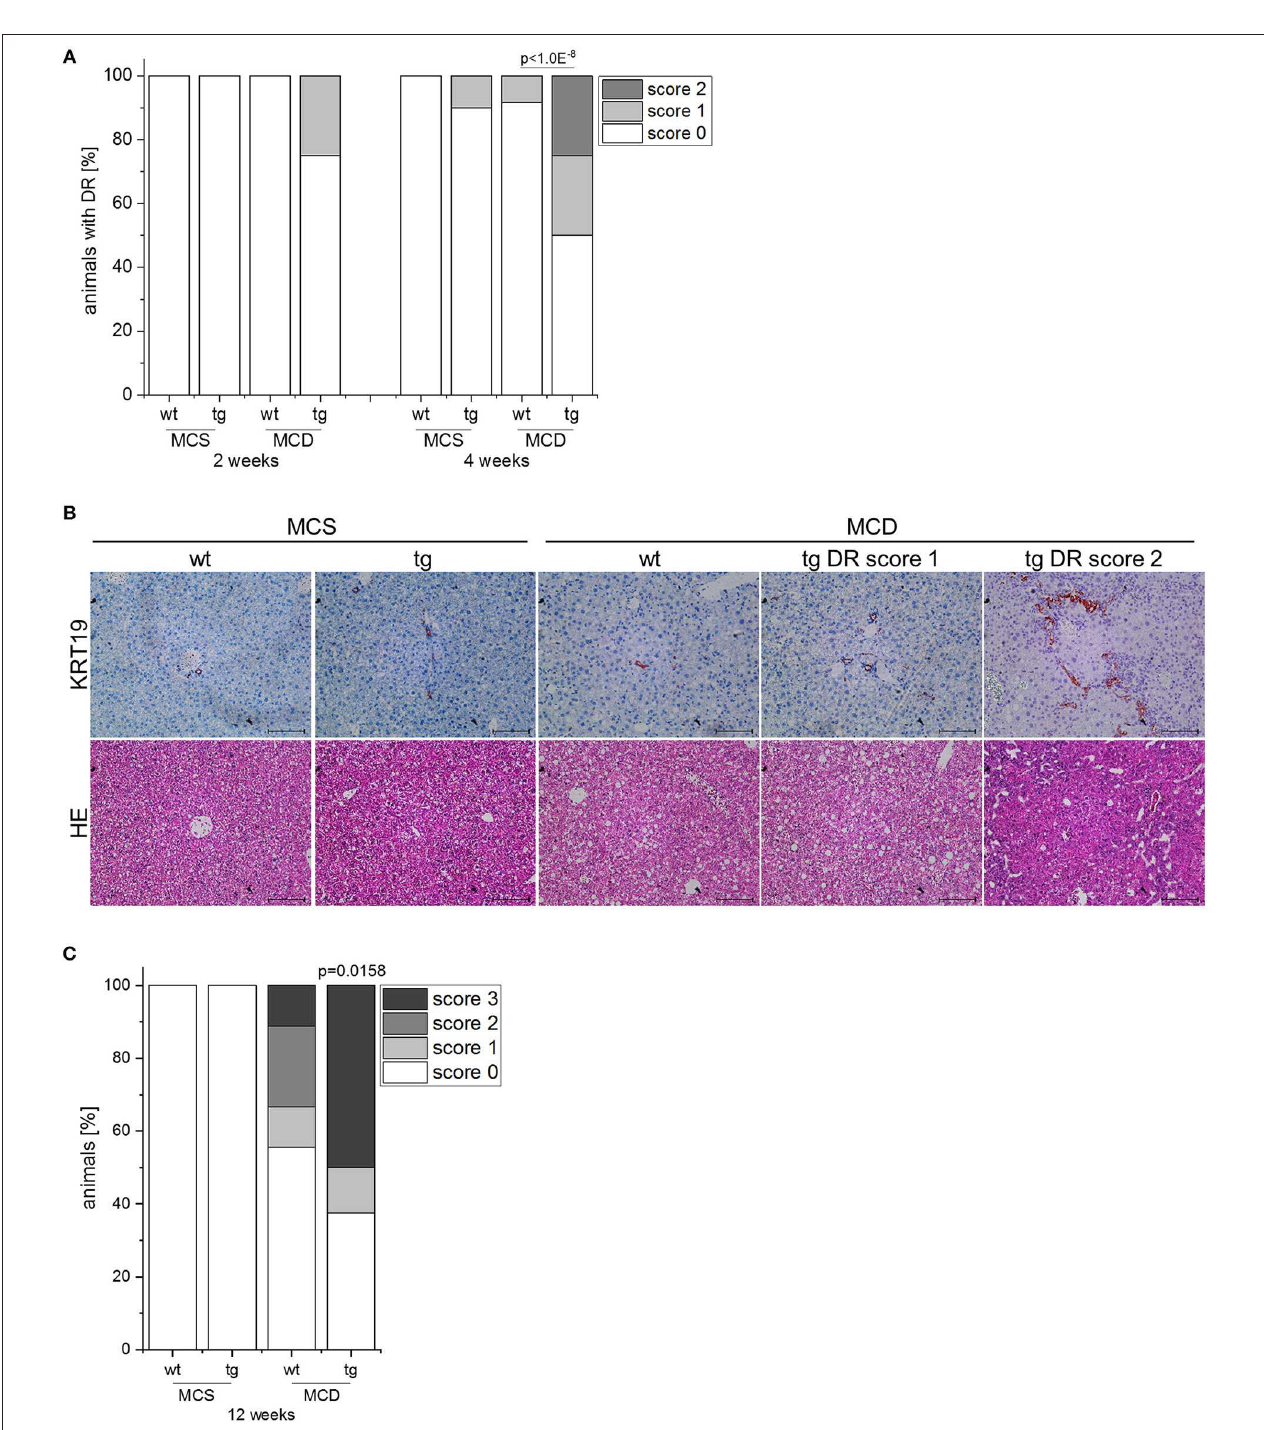
FIGURE 3 | IMP2-2 expression accelerates DR in the MCD model. (A) Histological scoring of DR in IMP2-2 transgenic (tg) and wildtype (wt) mice, which were fed either a methionine-choline deficient (MCD) diet or a methionine-choline supplemented (MCS) control diet for 2 and 4 weeks (2 weeks: MCS: n = 10 per genotype, MCD: n = 12 per genotype; 4 weeks: n = 10 per genotype, MCD: n = 12 per genotype). The p -value was calculated by chi-square test. (B) Representative images of HE and KRT19 stainings from wt and tg mice on MCS or MCD diet for 4 weeks. For tg mice representative images of DR score 1 and DR score 2 are shown (scale bars: 100 µ m). (C) Histological scoring of Sirius red stained sections for fibrosis of wt and tg mice, which were fed either a methionine-choline deficient (MCD) diet or a methionine-choline supplemented (MCS) control diet for 12 weeks (MCS: n = 9–11 per genotype, MCD: n = 9–10 per genotype).